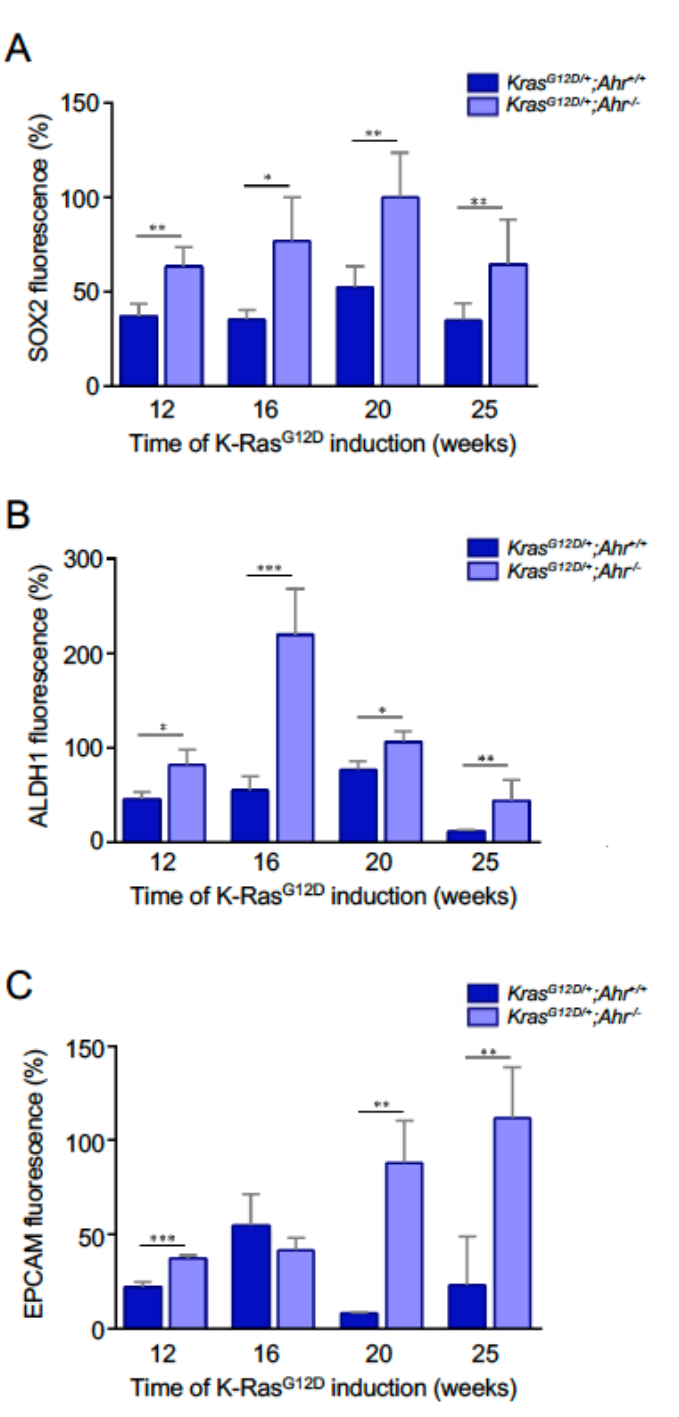
Figure 4. Quantification of lung progenitor cells expressing tumor-associated SOX2, ALDH1A1 and EPCAM. Lung sections from K-Ras G12D/+ ; Ahr +/+ and K-Ras G12D/+ ; Ahr − / − mice (see Figure 3) were quantified for the presence of SOX2 ( A ), ALDH1A1 ( B ) and EPCAM ( C )-positive cells during K-Ras G12D induction from 12 to 25 weeks. Data are shown as mean + SD (* p < 0.05; ** p < 0.01; *** p < 0.001). Number of replicates ( N = 3) and measures taken from 4–6 fields for each replicate.